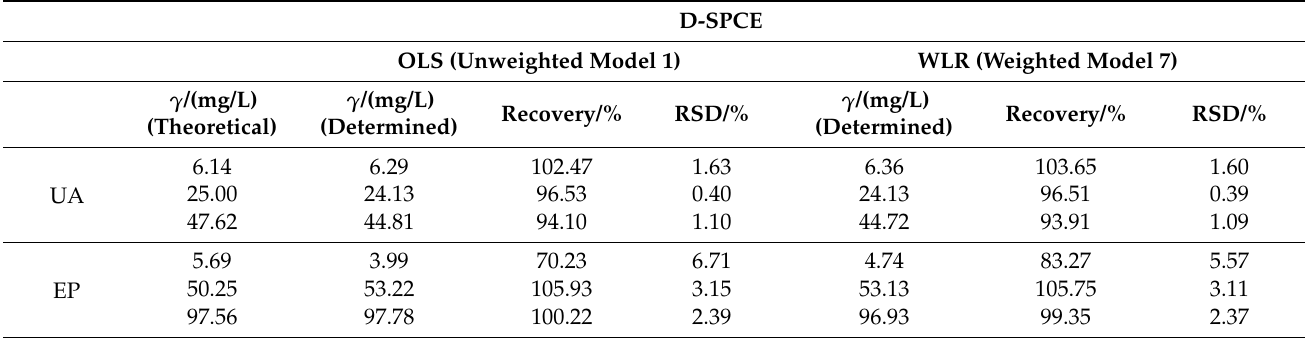
Table 4. Average recovery and RSD values for UA and EP, calculated with unweighted model 1 (OLS method) and weighted model 7 (WLR method), obtained by